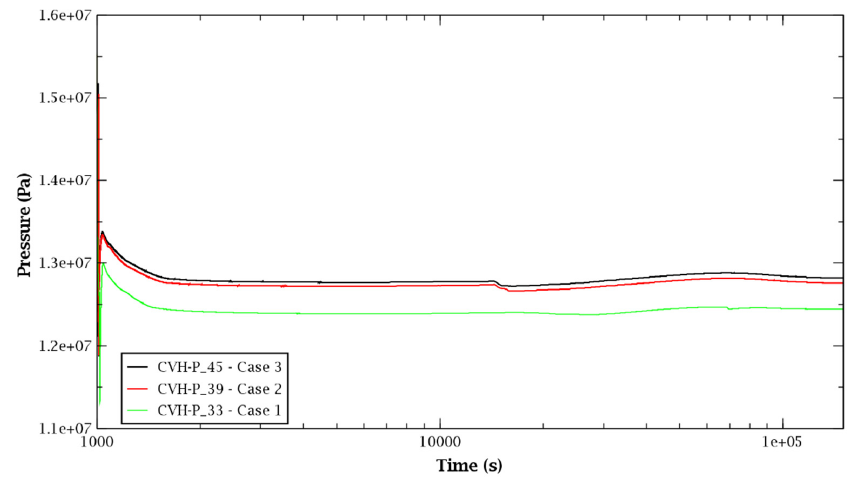
Figure 6. Pressure trend after the rupture: primary side.